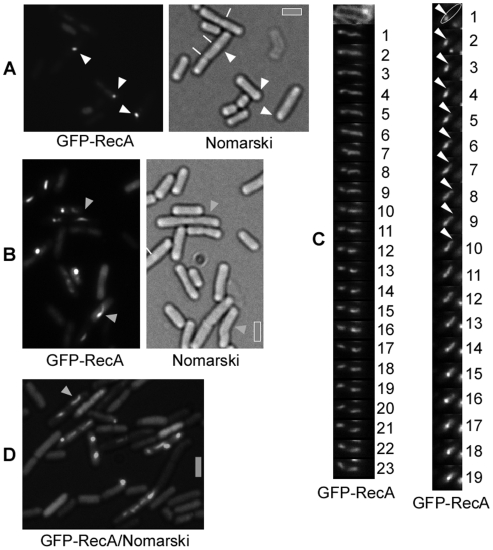
Fluorescence microscopy of GFP-RecA in cells grown to competence.(A) GFP-RecA forms polar foci in wt competent cells, and (B) threads after addition of chromosomal DNA. (C) Time-lapse with 1 min intervals of cells containing a GFP-RecA thread. Left panel: the upper image shows the outline of the cell through a membrane stain. The lower panels show an extended GFP-RecA thread that changes its shape every minute. Right panel: nucleation and extension of a RecA thread within one cell. In the upper image, a cell contains a GFP-RecA focus from which a thread extends for several minutes, as indicated by the white triangle. The thread appears to retract after minute 15, although it is unclear if this is based on true retraction or bleaching. (D) GFP-RecA threads after addition of supercoiled plasmid DNA. White triangles indicate polar foci, and grey triangles threads. Septa between cells are indicated in (A) by white lines. Grey bars 2 µm.